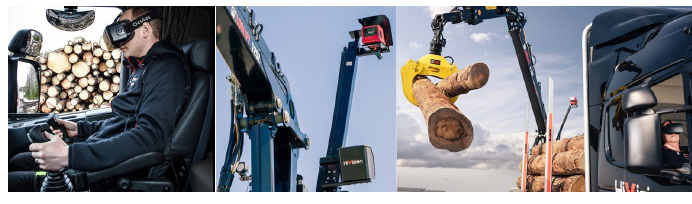
Figure 8. Hiab HiVision VR system [136].